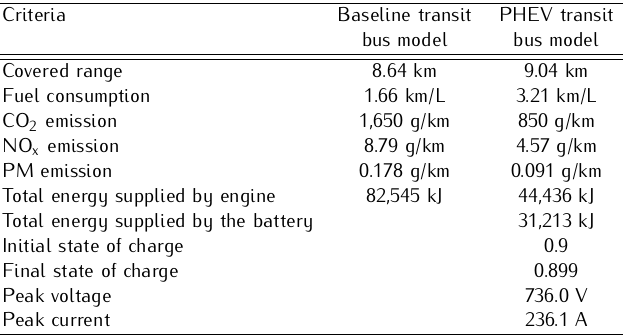
Table 6. Comparison of simulation results of PHEV bus with the baseline